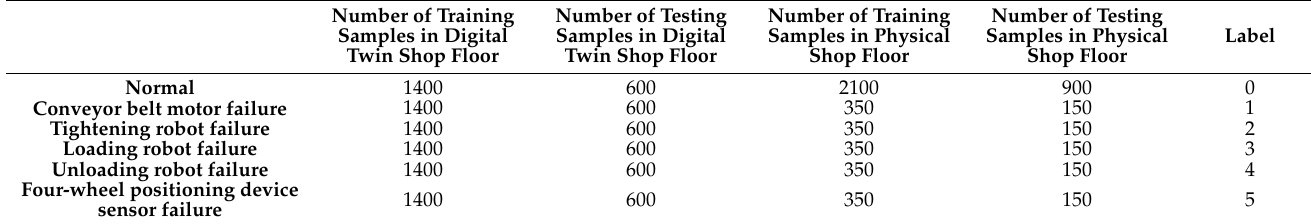
Table 1. Product line fault diagnosis sample parameters.